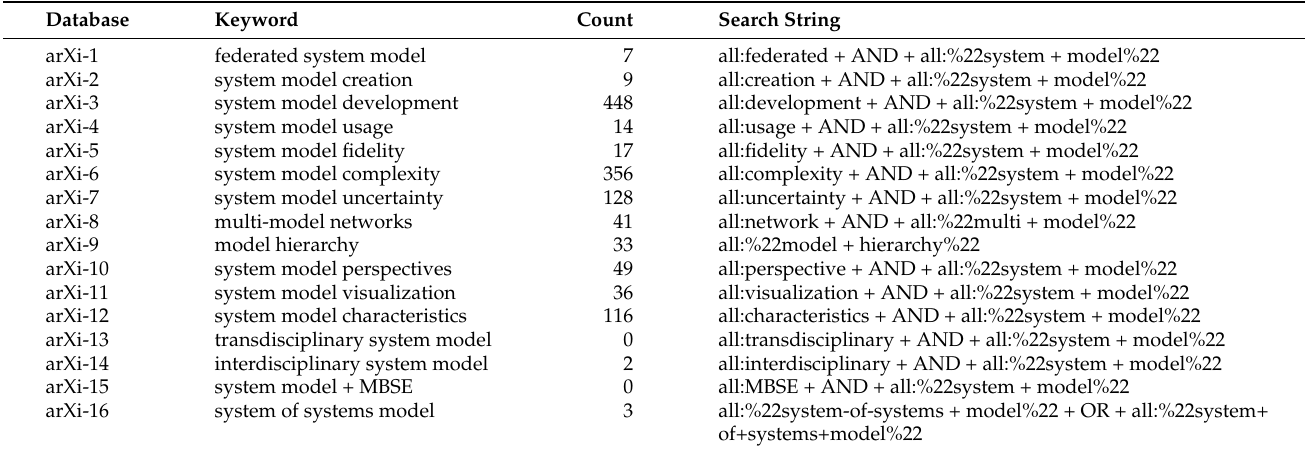
Table A5. Used keywords—arXive.org.